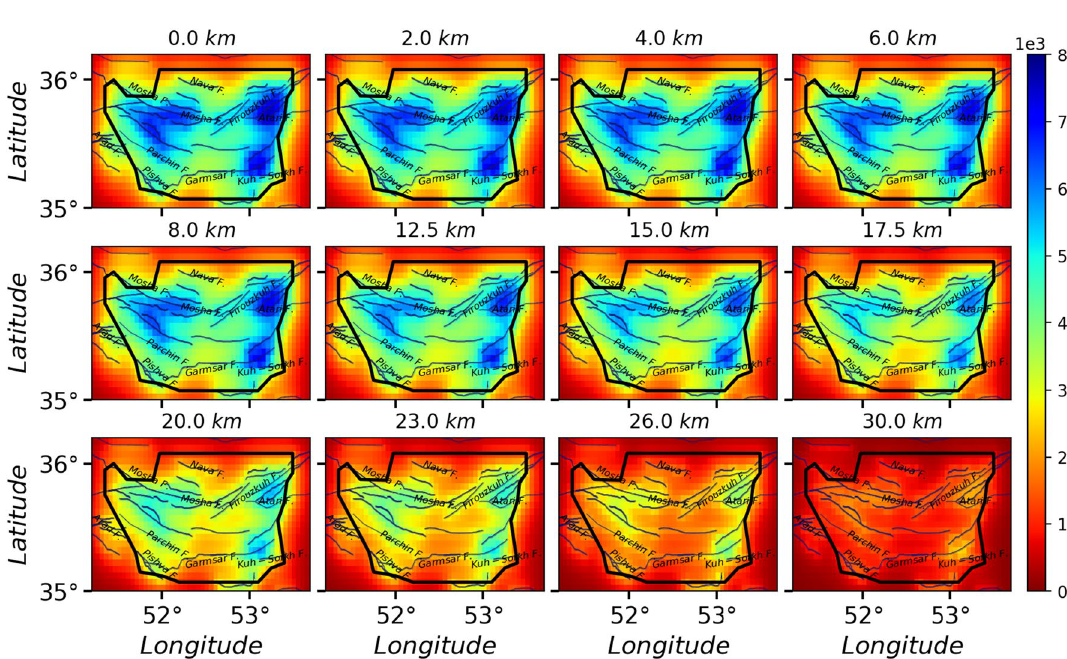
Figure 6. The activity Field for 1000000 avalanches in the whole space, wherein each avalanche starts from a Fault site. The solid lines and black border represent the known faults and the region with good resolution,